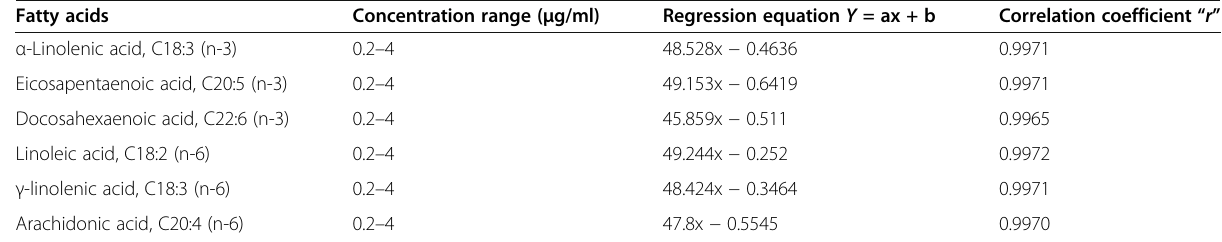
Table. 6 Linearity with sample concentration Fatty